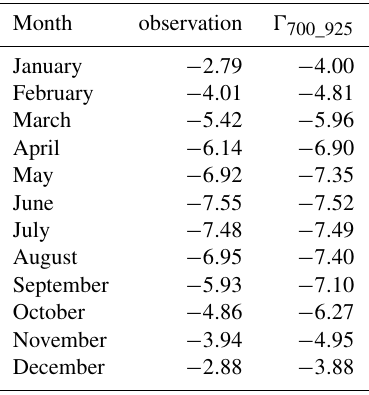
Table 4. Average monthly lapse rates ( ◦ Ckm − 1 ) for the 24 sites in